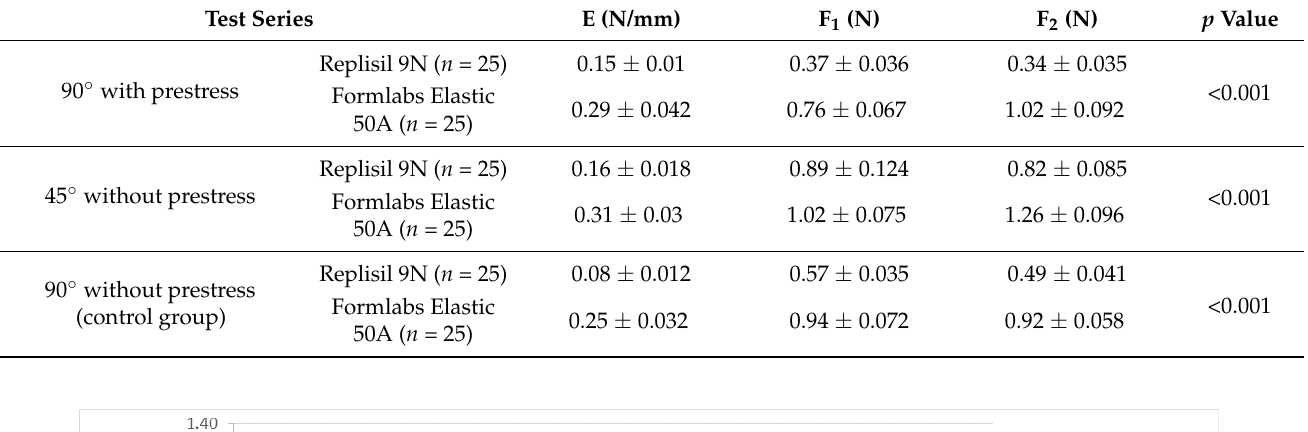
Figure 7. Force displacement diagram of one sample penetration at 90° without prestress. The force is presented in Newton and the displacement is presented in millimeters.